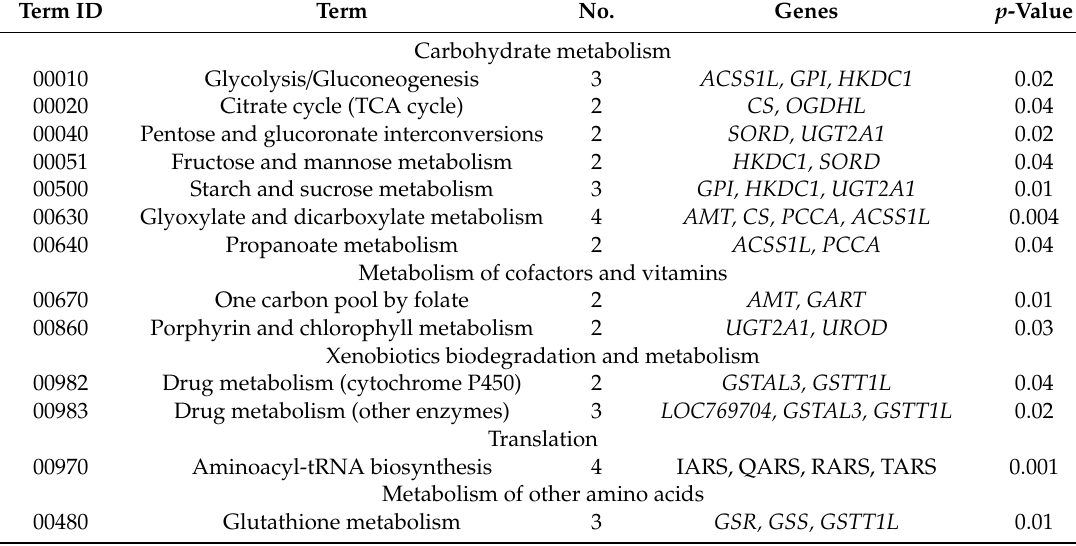
Figure 3. Gene ontology terms of positive effected proteins of differentially expressed proteins by early heat exposure. The x ‐ axis unit of percentage (%) is ‘the number of genes that included in the GO term/the total number of genes in GO term’. Table 1. List of KEGG